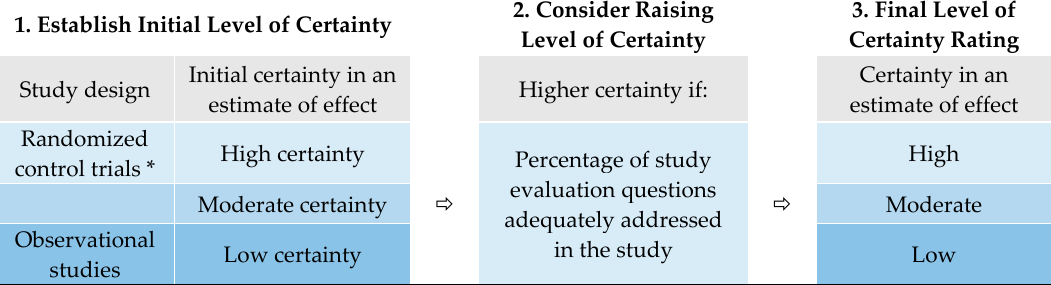
Figure 4. The approach used for developing level of certainty ratings for each study outcome. * No randomized control trials were identified in this review.